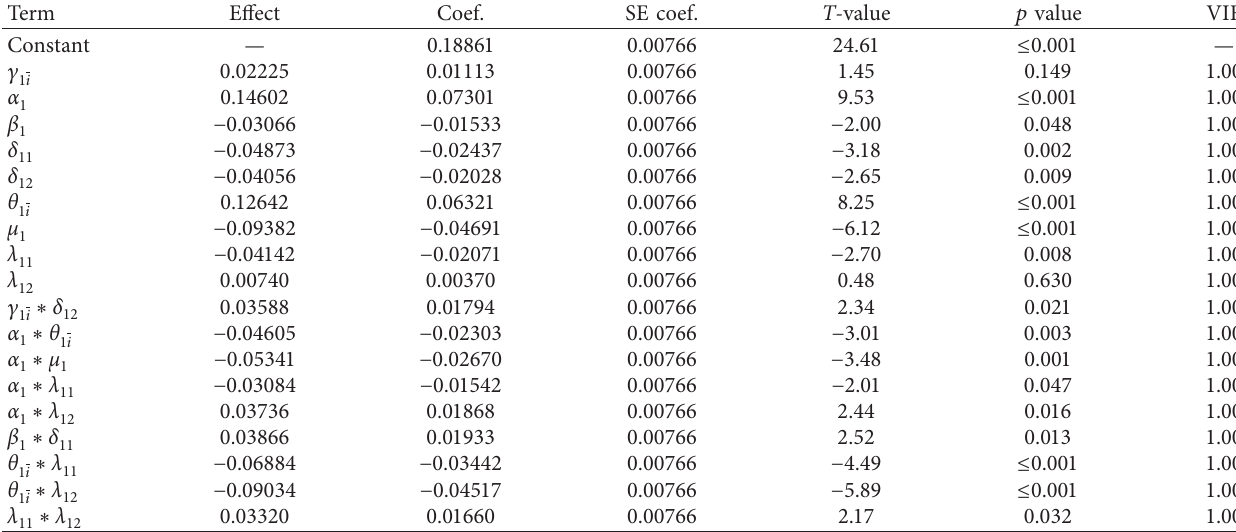
Table 4: Coded regression model